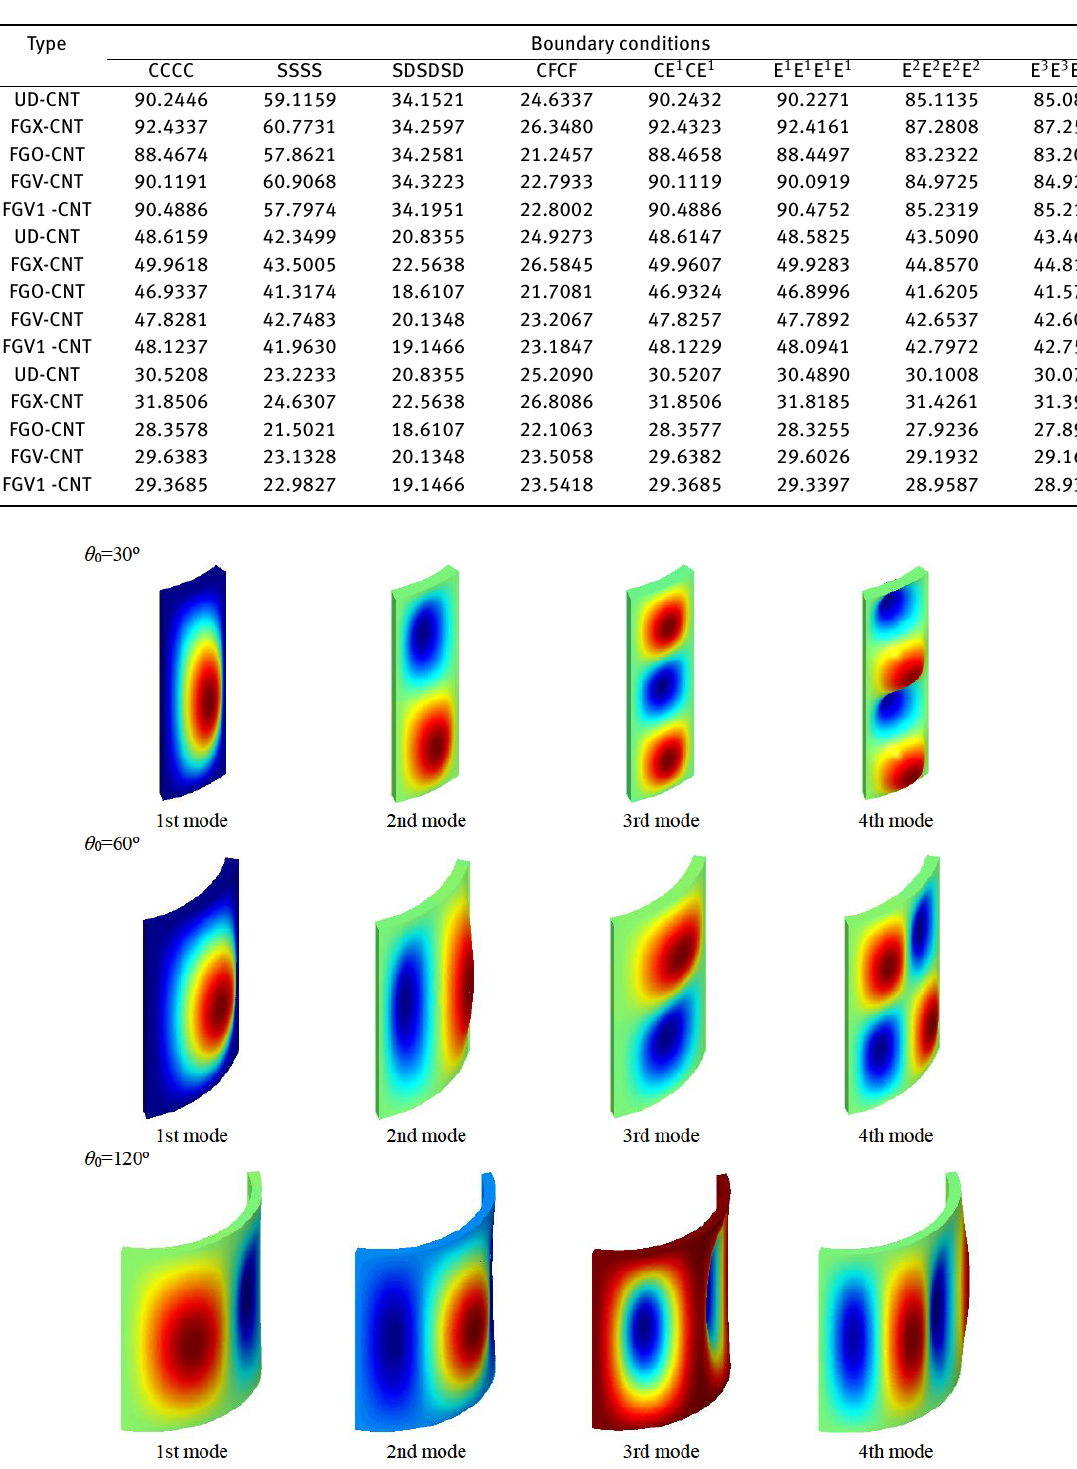
Figure 5: Mode shapes of the CCCC FG-CNT reinforced composite panel with UD-CNT type and volume fraction V tcnt